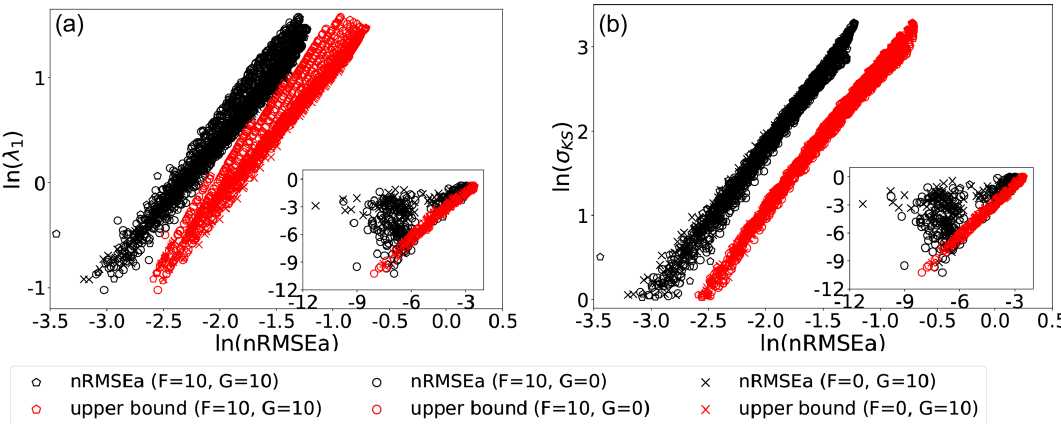
Figure 7. Scatter plots of λ 1 (a) and σ KS (b) against the nRMSEa for experiments with observations of the entire state vector at each time step. The theoretical analysis error upper bounds are also displayed (red markers). The log scale is used on both axes. The experiments use the model forcing given in the legend and the energy rate and dissipation in the range (α × γ) ∈ [ 0 . 1 , 3 ) ×[ 0 . 3 , 1 . 8 ) with an interval of 0 . 1 × 0 . 05. The stable configurations ( σ KS ≤ 0) have been excluded. The inset shows the weakly unstable model configurations (0 < σ KS ≤